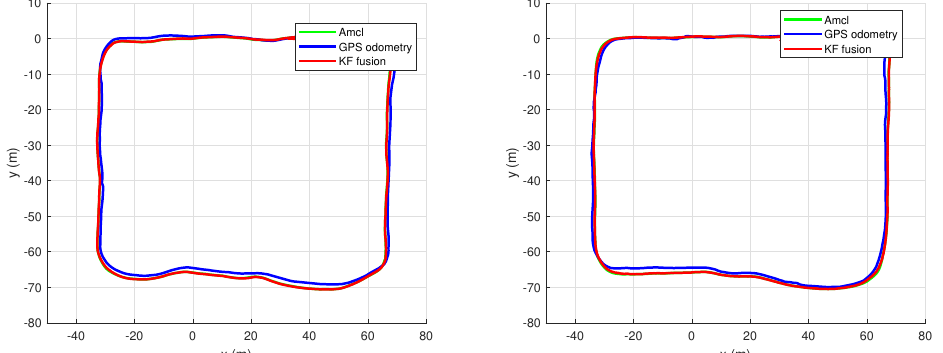
Figure 14. Trajectories through the R 1 path expressed by localization using the fusion described in Section 5. ( left ) Using GNSS standalone. ( right ) Using GNSS floating point. In both cases, the fusion gives more weight to AMCL, because the robot is inside the map during the whole trajectory.